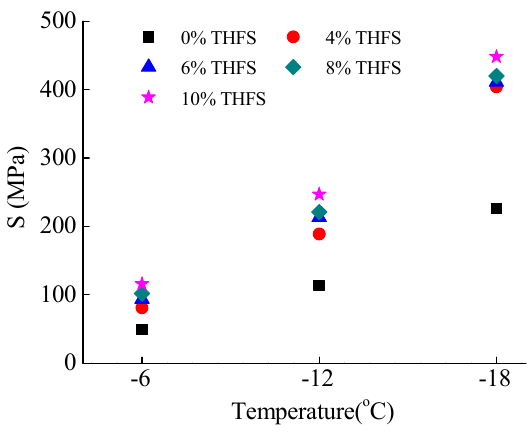
Figure 6. S Values of Asphalt Binders over Temperatures.